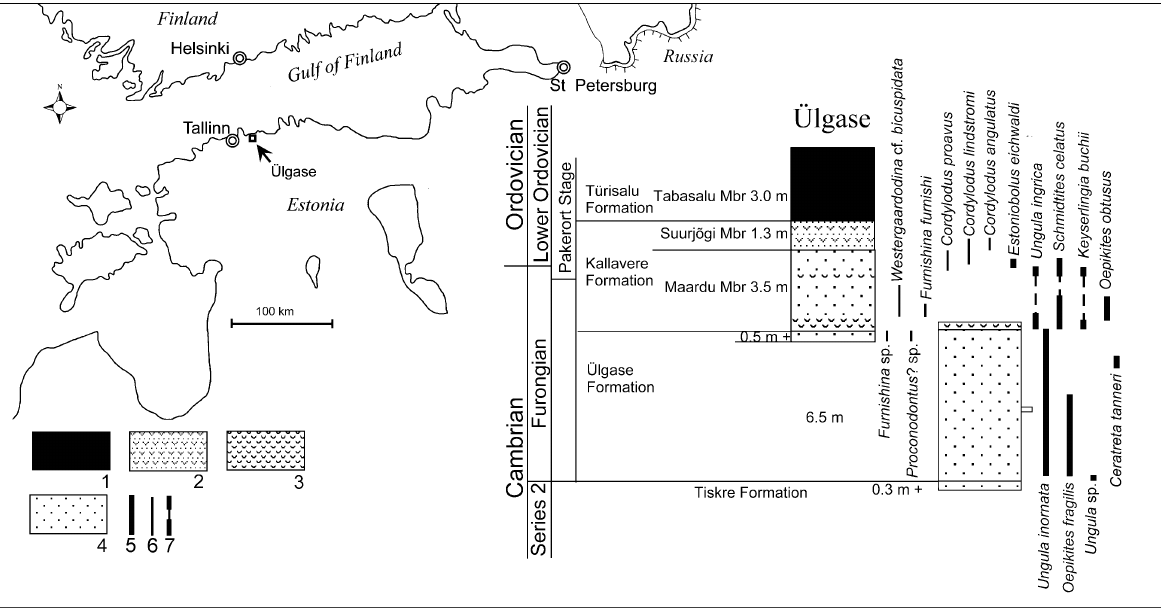
Fig. 1. Generalized map of Estonia and adjacent areas, showing the location and the sections of the (cid:220)lgase outcrop (after Puura 2004). The described specimen of Ungula inornata is collected from the sandstones from an interval 3.0(cid:150)3.2 m above the base of the (cid:220)lgase Formation (marked with an open rectangle on the right side of the lithological column). 1, kerogenous shale; 2, sand and sandstone yielding lingulate debris; 3, lingulate coquina and conglomerate; 4, sand and sandstone; 5, lingulate brachiopods; 6, conodonts and graptolites; 7, part of a range with no occurrences documented. Mbr,